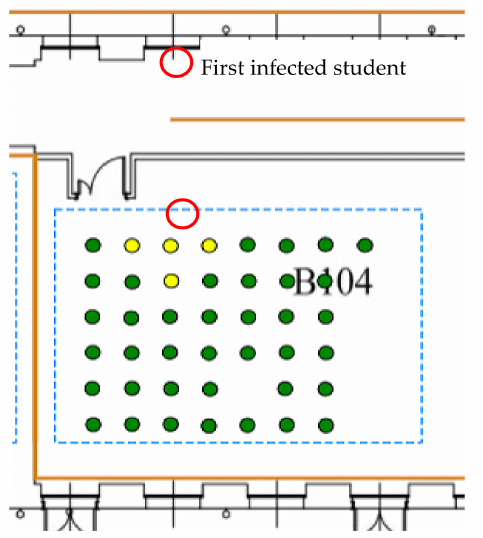
Figure 9. Example of infection in a classroom containing a latent